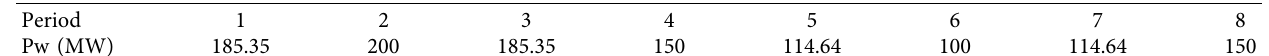
Table 3: The wind power output data.